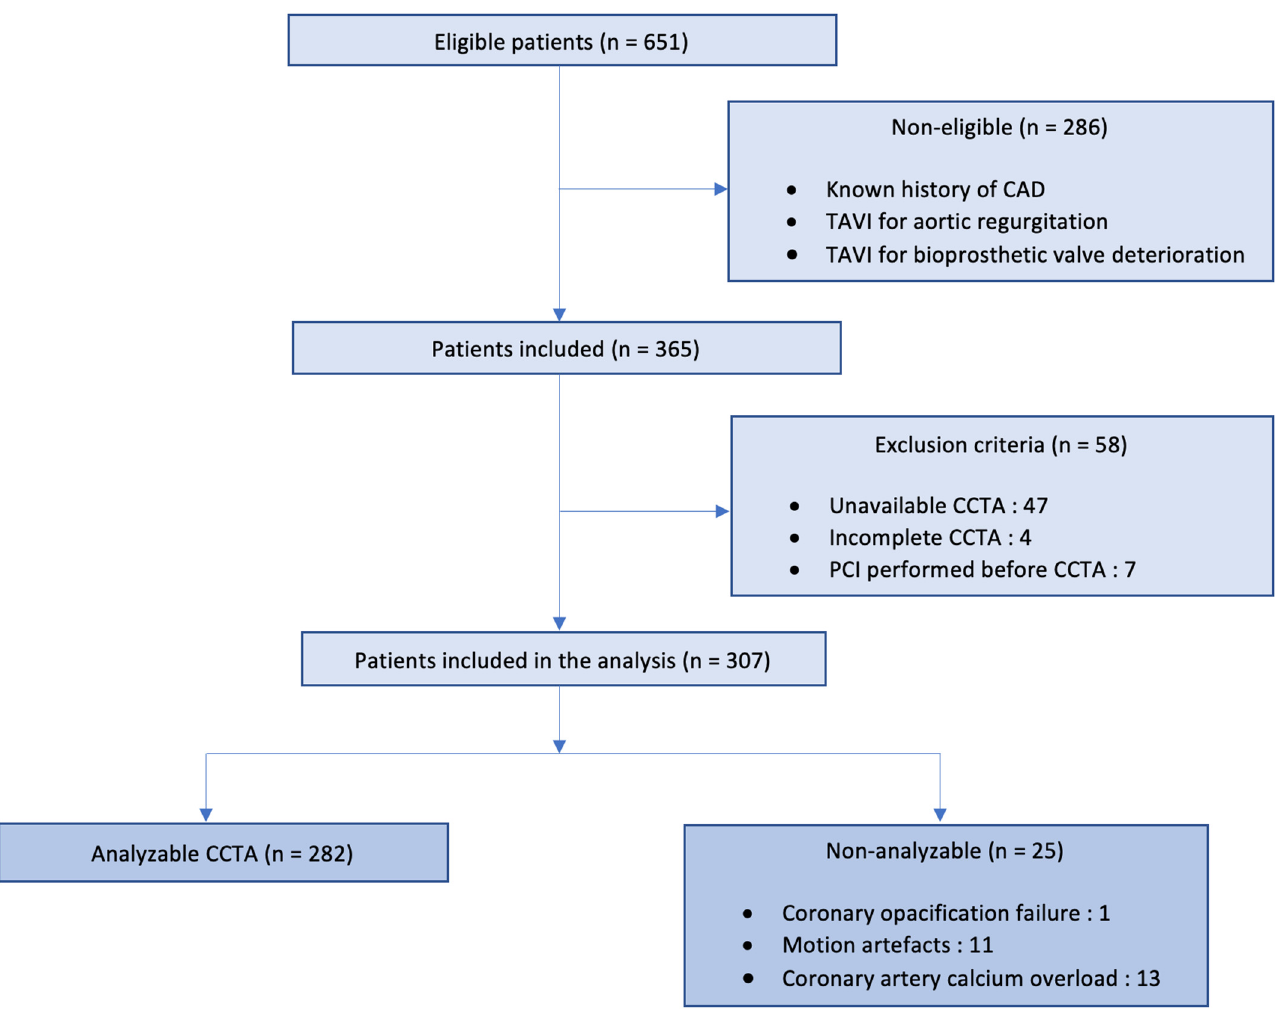
Figure 1. Flow chart diagram.